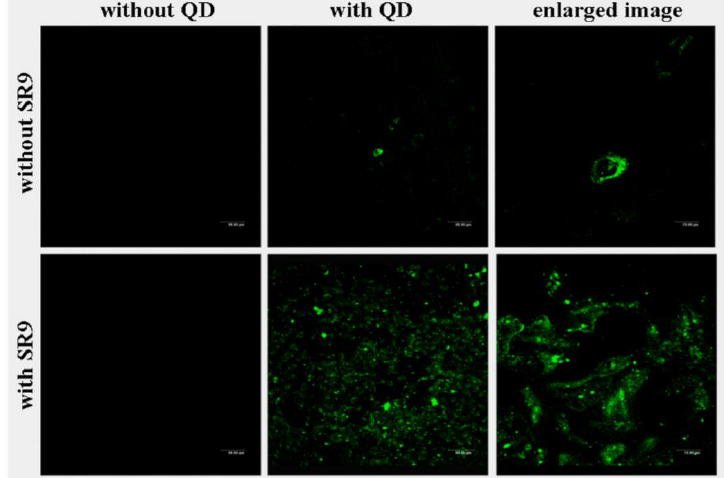
Figure 6. Confocal images of cellular uptake of CPP/quantum dots different combinations of free SR9, free quantum dots (QD) and SR9/QD complexes. Adapted from Journal of Nanoscience and Nanotechnology with permission from correspondent author Han-Jung Lee, published by HHS Public Access 2010, Copyright 2010 [97].